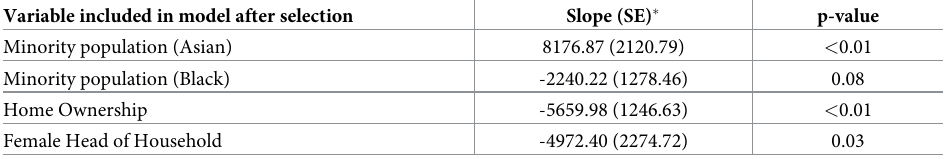
Table 3. Stepwise-selected regression model of the impact of census block group demographic and socioeconomic variables on ambient UFP number concentrations. Variable included in model after